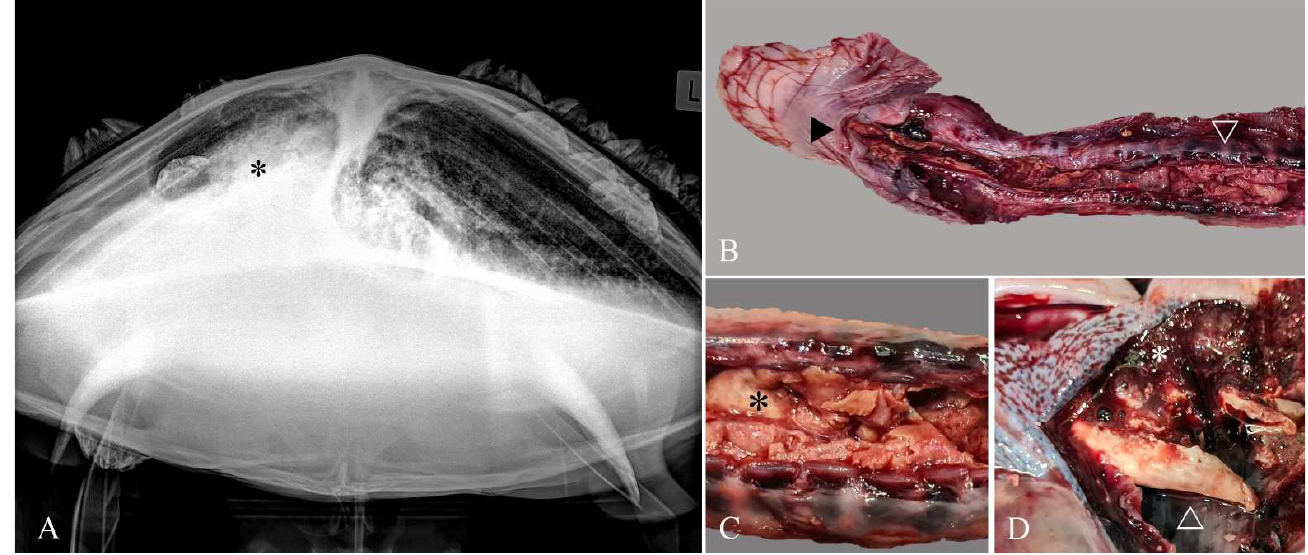
Figure 1. Necrotizing tracheitis and bronchopneumonia due to Serratia proteamaculans infection. Imaging and gross pathology. ( A ) Extensive areas of increased soft tissue opacity (*) were present bilaterally on craniocaudal radiographs. ( B ) From the glottis ( ► ), the tracheal mucosa was extensively ulcerated ( ∇ ) and replaced by diphtheritic membranes composed of fibrin and necrotic debris. ( C ) Ulcerated tracheal mucosa filled with diphtheritic membrane (*), and ( D ) Bronchi partially occluded with a diphtheritic membrane plug (Δ) and hemorrhagic pulmonary parenchyma (*).